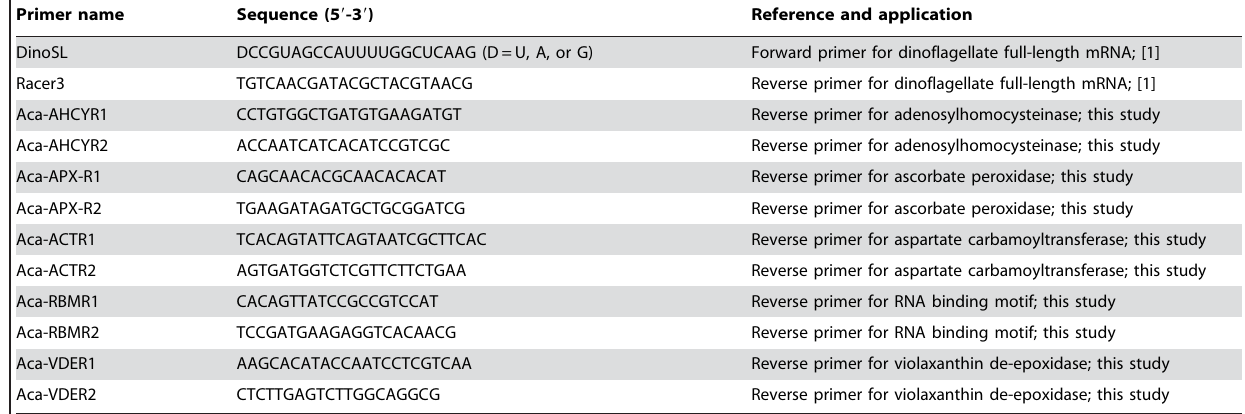
Table 1. Primers used in this study.